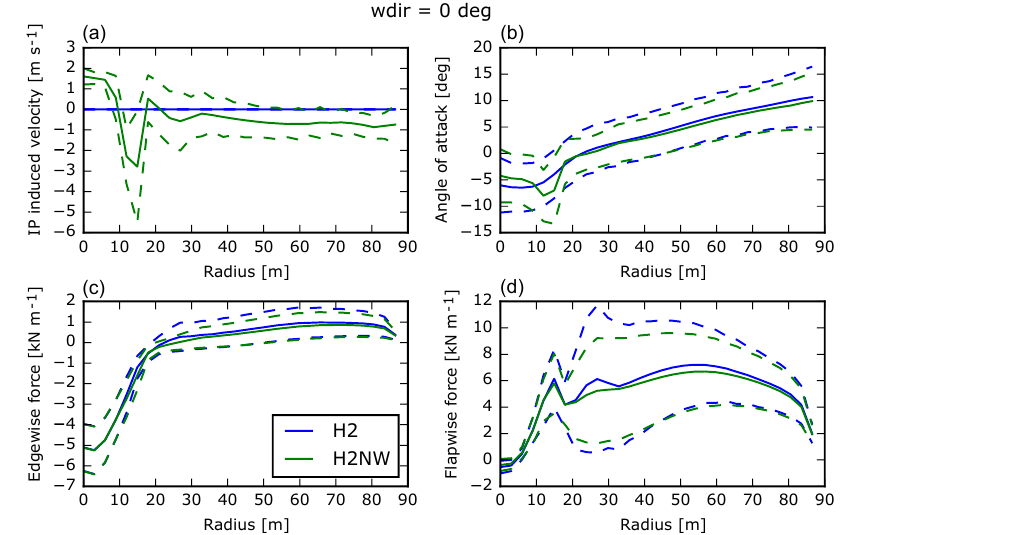
Figure 11. Distribution of induction, AOA, and loads for the upward-pointing blade. The mean values are shown as solid lines, and the dashed lines indicate the standard